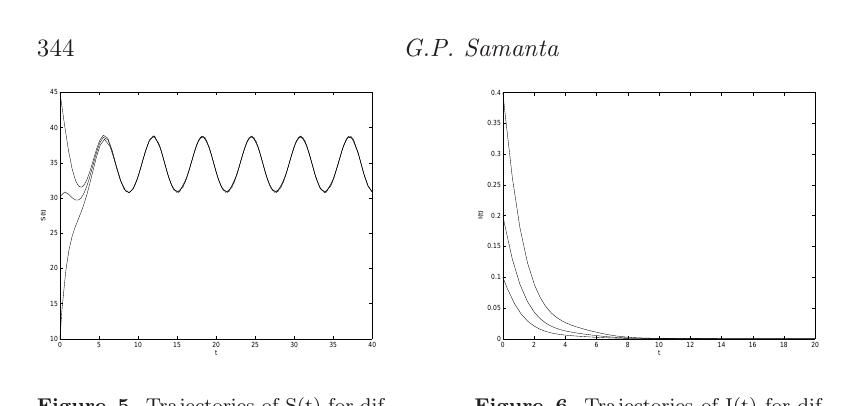
Figure 5. Trajectories of S(t) for dif- ferent initial conditions.